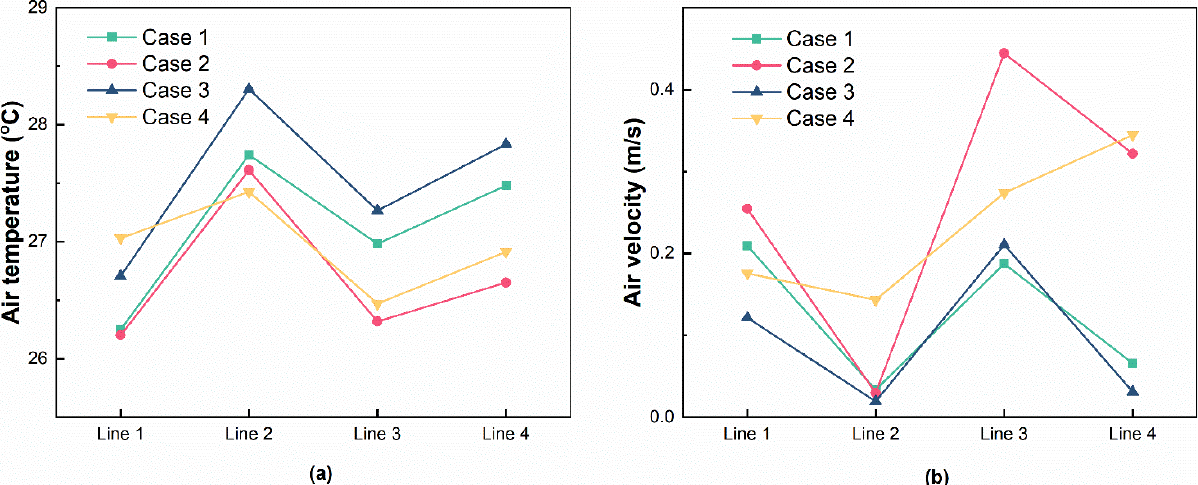
Figure 9. Lines 1 – 4 of four experimental cases at 1.1 m above floor: ( a ) air temperature; ( b ) air ve-